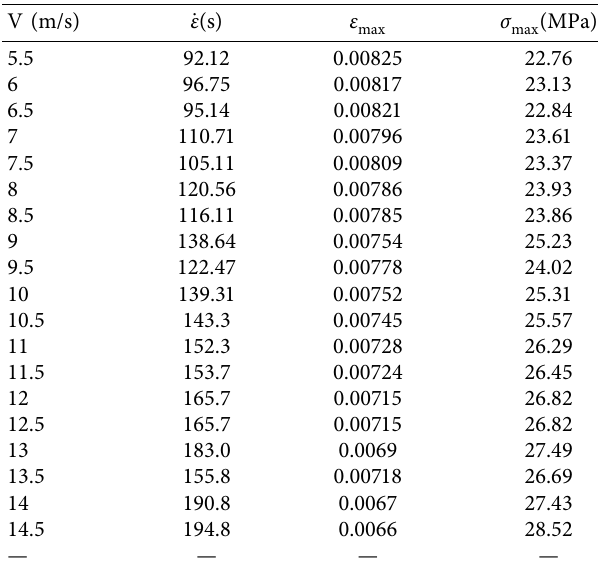
Figure 4: Dynamic balance for the original data. Table 1: Impact test results of granite